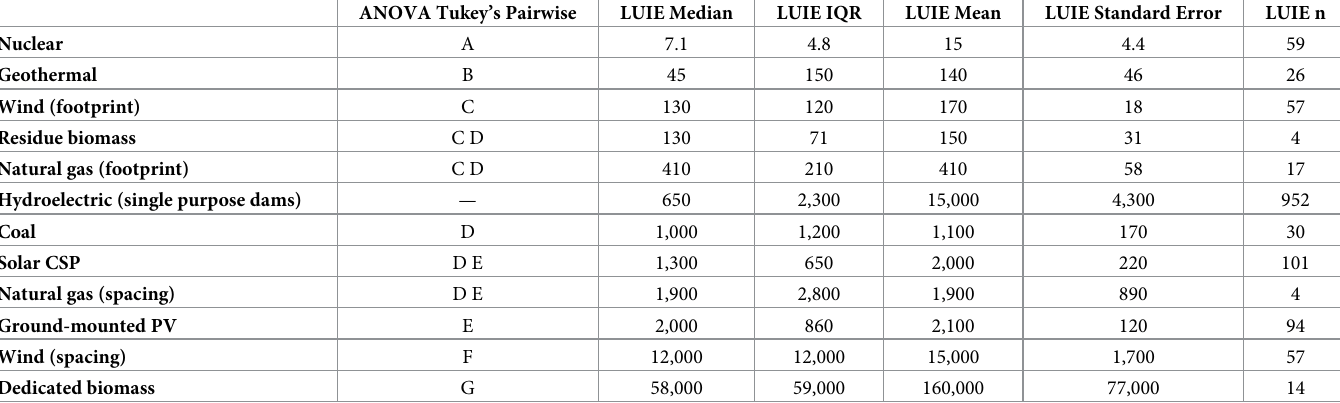
Table 1. Land use intensity of electricity (LUIE) showing total direct and indirect land use (ha/TWh/y). We show median, mean, and interquartile range (IQR) for the LUIE, along with the number (n) of observations for each power source. We performed an ANOVA analysis with Tukey’s pairwise comparisons on the log 10 of LUIE for different sources, which is represented by different letters. Sources that share a letter have mean LUIE that are not statistically different. Hydroelectric was excluded from the ANOVA analysis because its variance was too